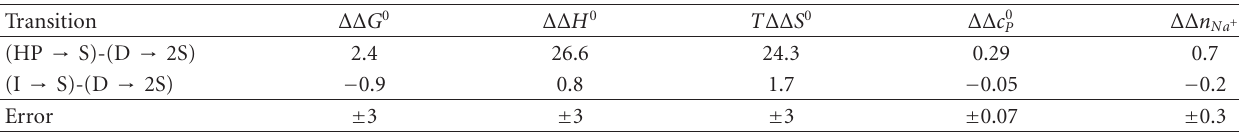
Table 2: Di ff erence thermodynamic stability parameters a at 25 ◦ C exhibiting the influence of the TCTC loop to the unfolding features of the hairpin forming oligonucleotide (HP).